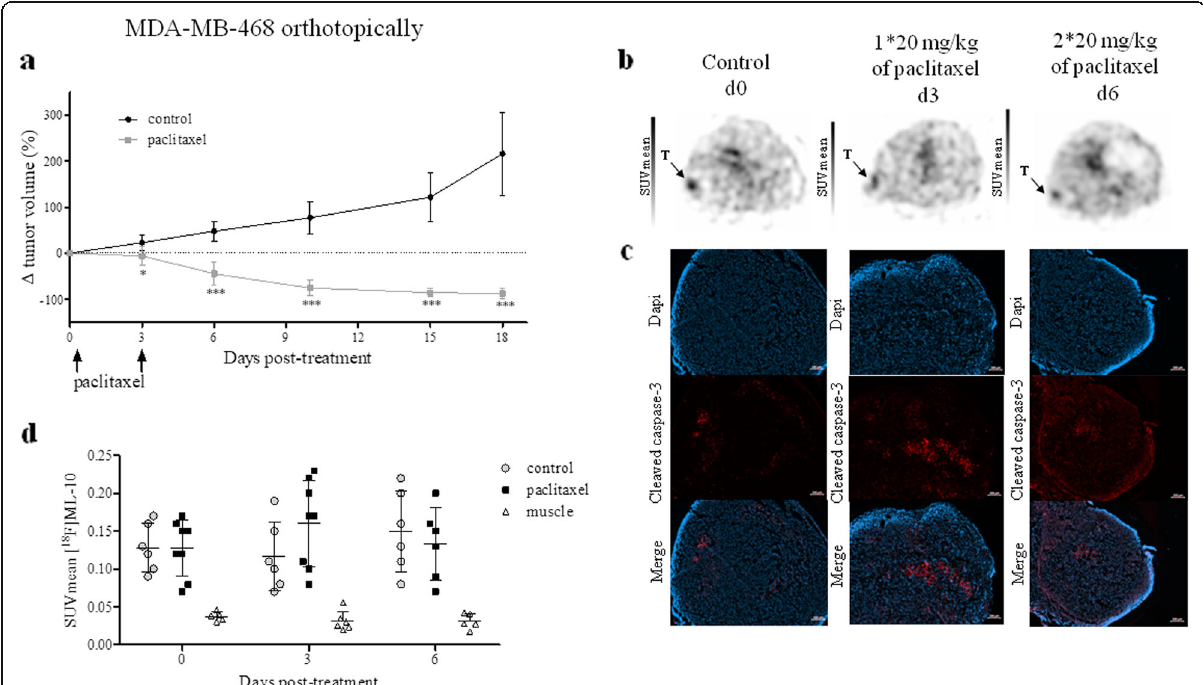
Fig. 10 Evaluation of early response by [ 18 F]ML-10 PET imaging on an orthotopic model. a Evaluation of tumor volume after two i.v. injections of paclitaxel (20 mg/kg) at a 72-h interval. Data are represented as mean ± SD. Compared to control, *** p < 0.001 (Mann-Whitney test). b Images of [ 18 F]ML-10 PET of representative MDA-MB-468 orthotopic xenograft model performed and 72-h post-treatment. T represented tumor. c Representative image of cleaved caspase of tumor tissues. d [ 18 F]ML-10 uptake expressed as SUVmean in tumor control, tumor treated and muscle at day 0, day 3, and day 6. Mann-Whitney test was performed (* p <